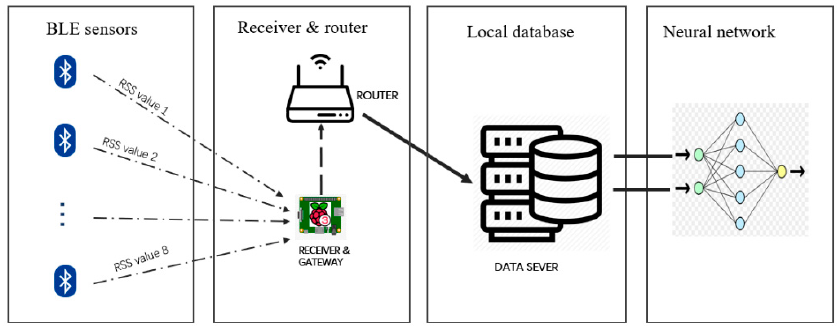
Figure 3. Overview of data flow for developed 3D positioning system.